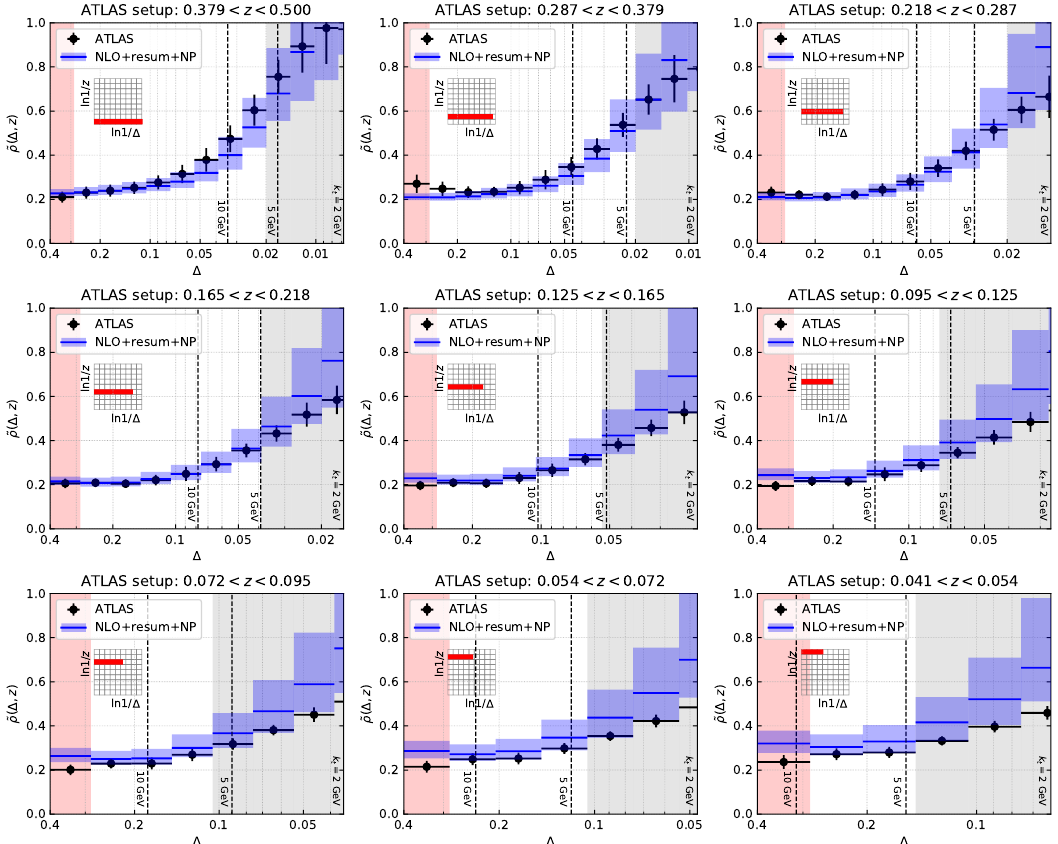
Figure 13. Same as (cid:12)gure 12 this time for slices at constant ln(1 =z